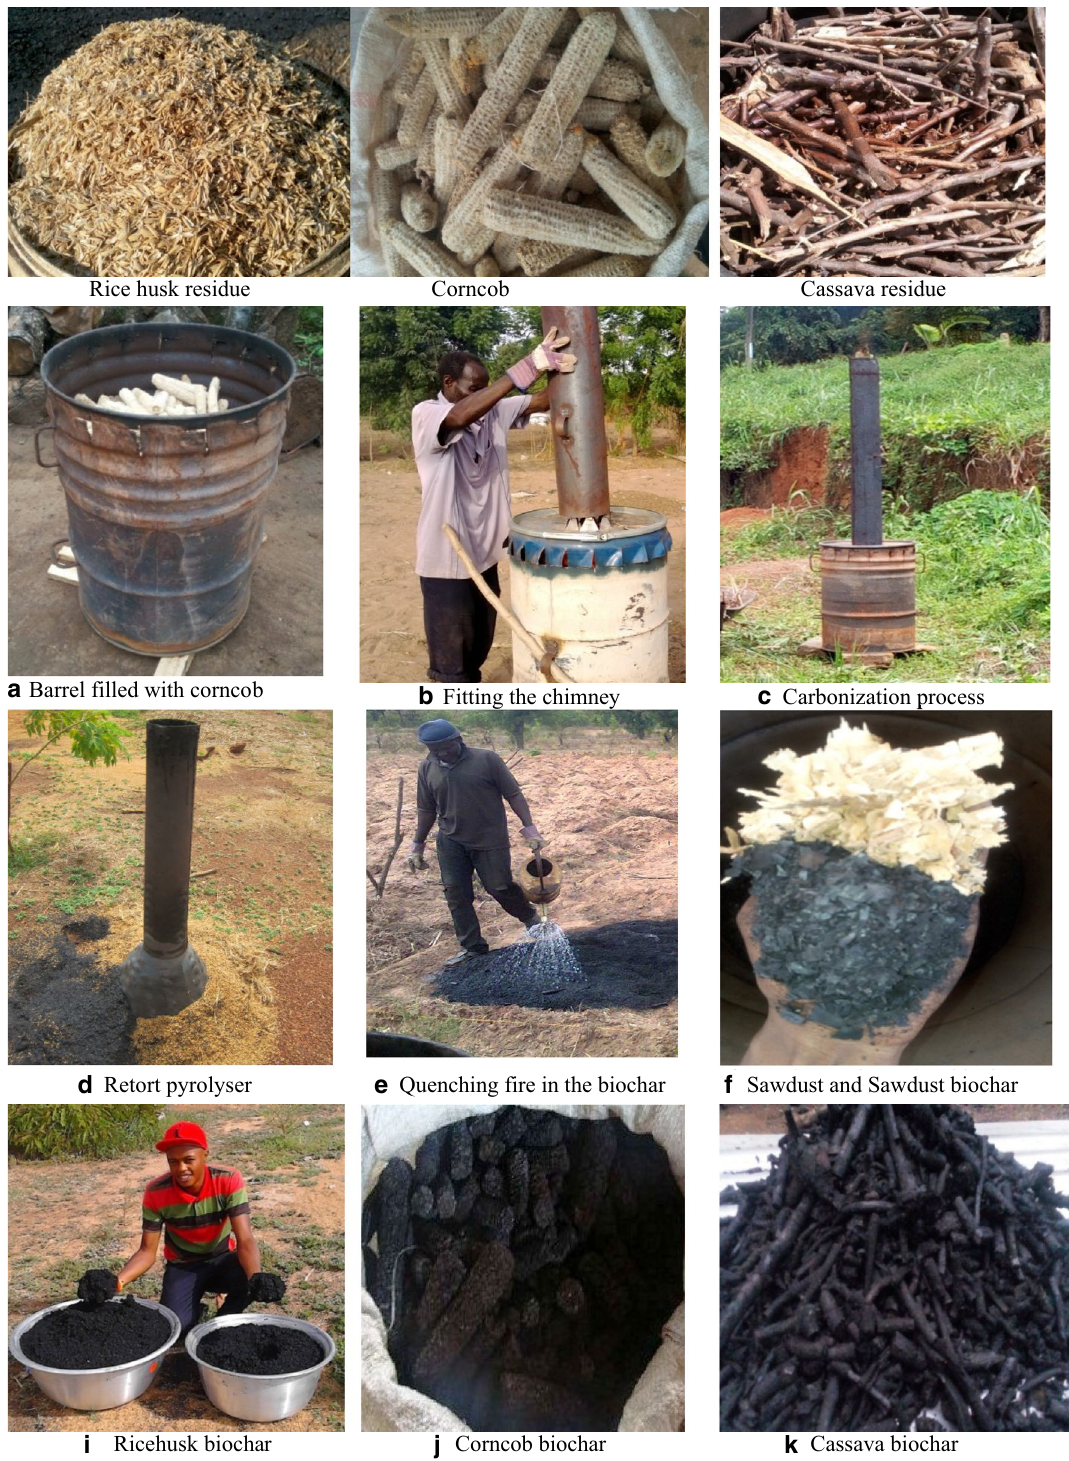
Fig. 1 Biochar production from selected crop wastes using the Elsa pyrolysis barrel. Source: Billa et al.